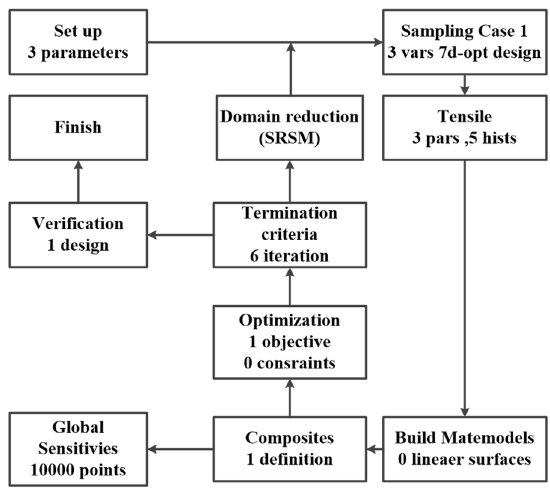
Figure 7 LS-OPT optimization process for the uniaxial tension specimen